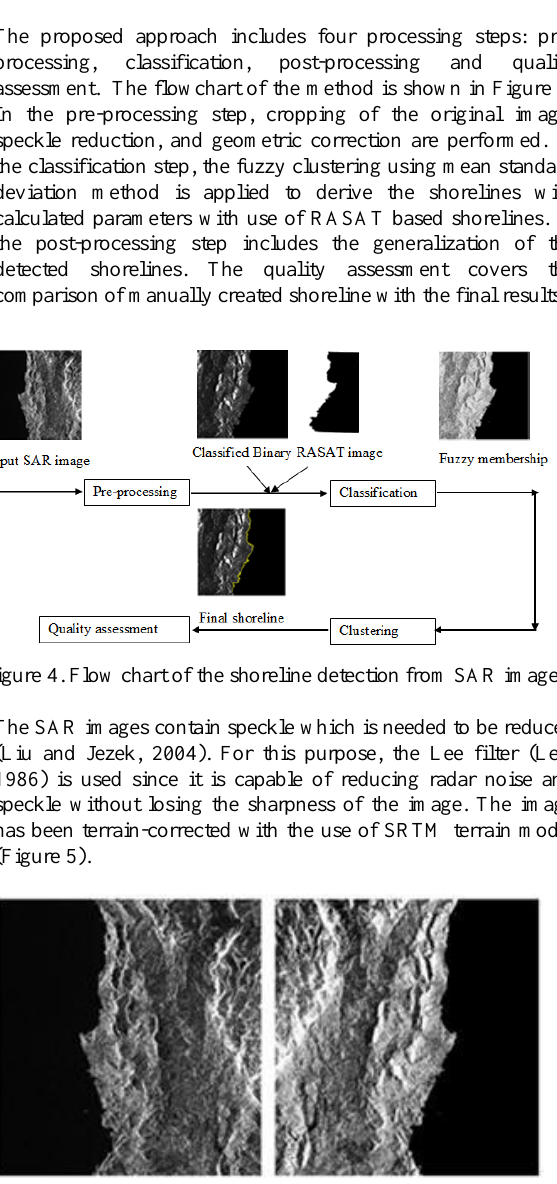
Figure 3. Land and Water-body segments